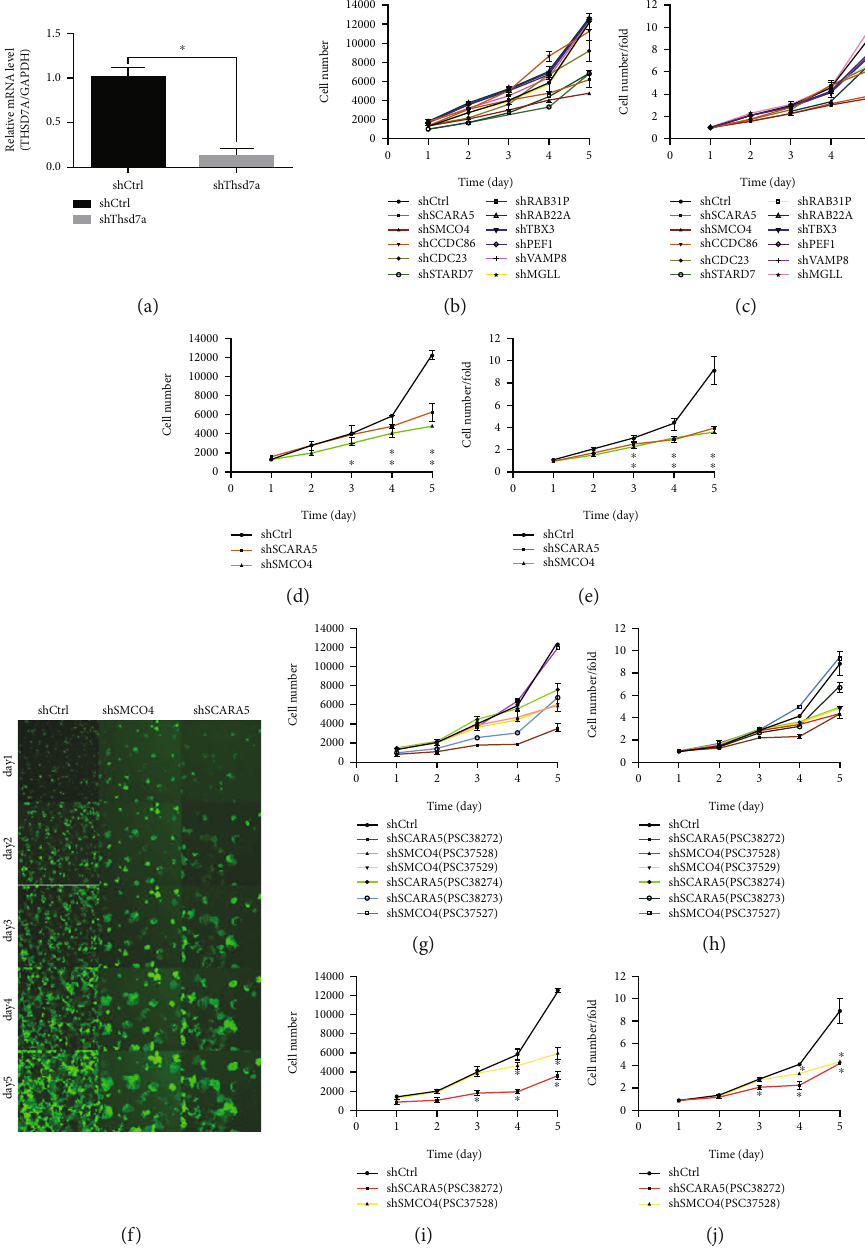
Figure 1: SCARA5 is the downstream driving gene of THSD7A . (a) Expression of THSD7A in the Eca109 cells after shRNA- THSD7A transfection was detected by qRT-PCR. (b) Cell proliferation curve for 11 candidate genes after shRNA transfection. (c) Cell proliferation fold change curve for 11 candidate genes after shRNA transfection. (d) Cell proliferation curve for the two strongly positive genes. (e) Cell proliferation fold change curve for two strongly positive genes. (f) Fluorescence fi eld pictures of the Eca109 cells from shCtrl, sh- SCARA5 , and sh- SMCO4 groups for fi ve days captured by Celigo imaging cytometer. (g) Cell proliferation curve for six interference targets of SCARA5 and SMCO4 . (h) Cell proliferation fold change curve for six interference targets of SCARA5 and SMCO4 . (i) Cell proliferation curve for the positive interference targets of SCARA5 and SMCO4 . (j) Cell proliferation fold change curve for the positive interference targets of SCARA5 and SMCO4 . ∗ P < 0 : 05